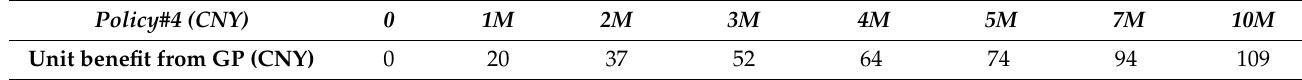
Table 5. Statistics of the unit benefit from GP.